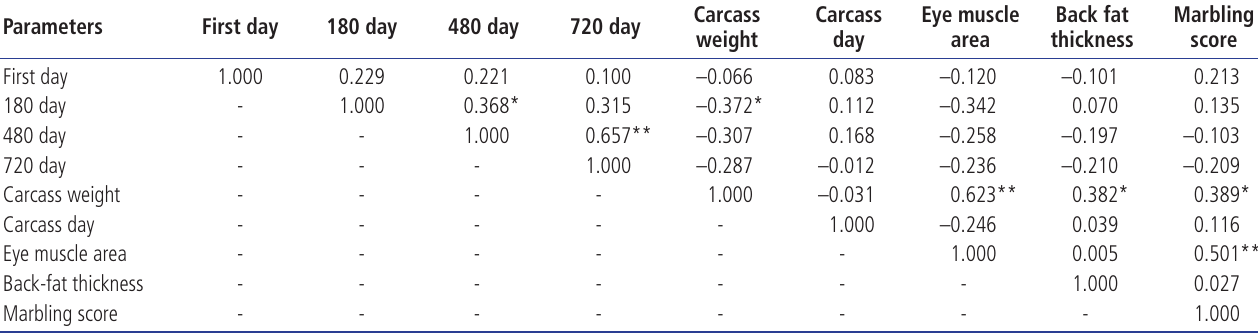
Table 5. Correlation analysis of growth pattern and carcass characteristics of low meat yield group Parameters